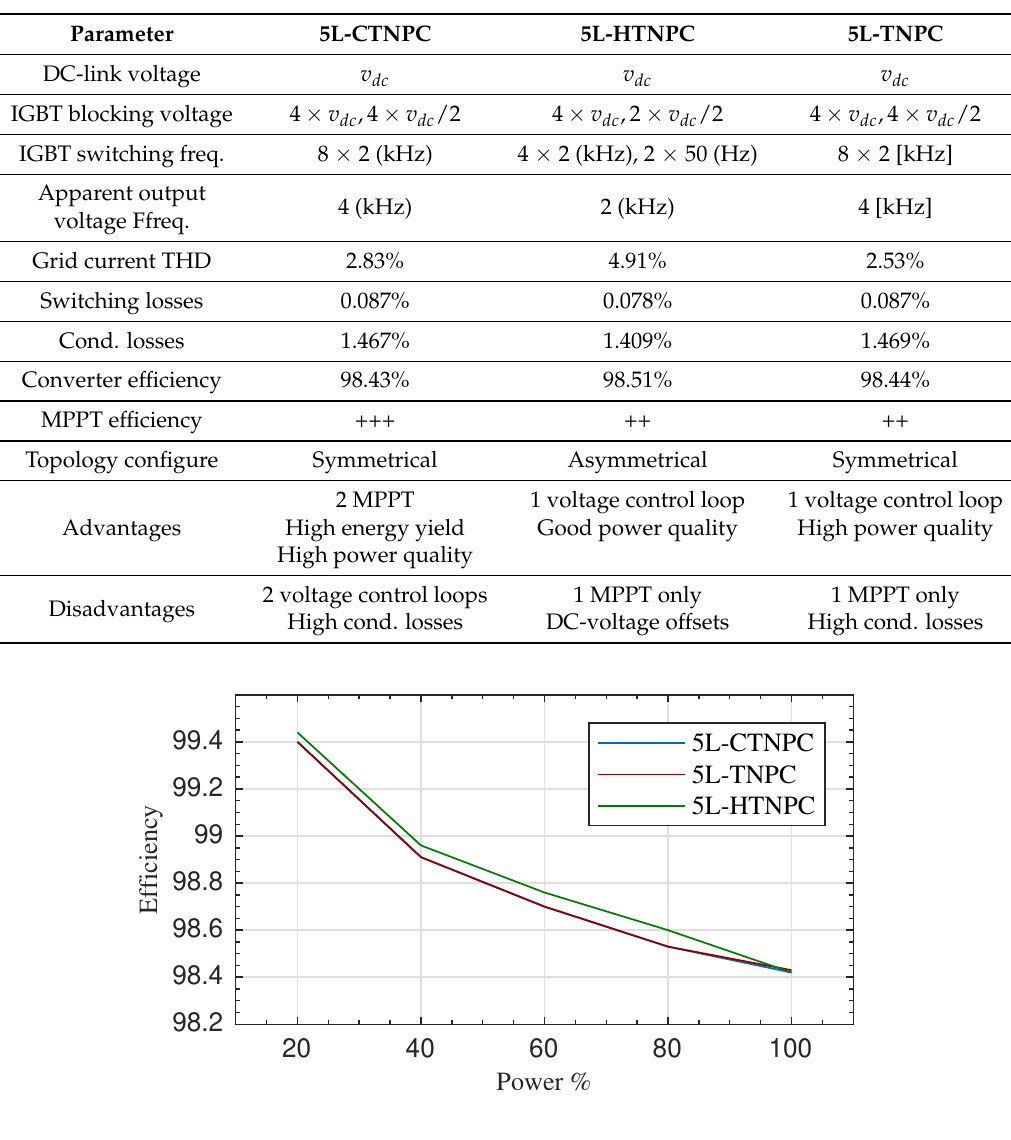
Table 3. Brief comparison between five-level T-type topologies.